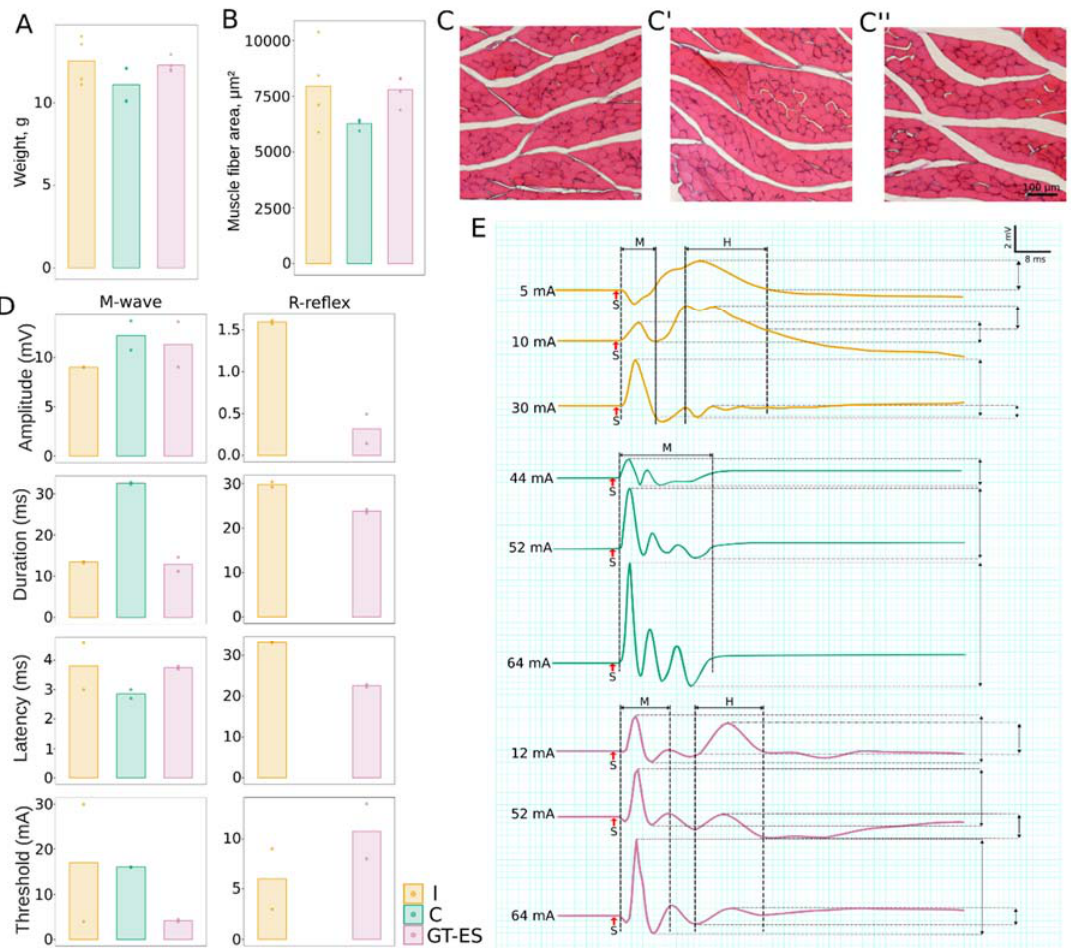
Figure 3. Assessment of hind limb skeletal muscles and an electrophysiological evaluation of M- and H-reflex. ( A ) Tibialis anterior muscles weighing analysis. ( B ) Evaluation of muscle fibers area in the tibialis anterior muscle. ( C , C ’, C ”) Cross sections of the tibialis anterior muscle stained with hematoxylin and eosin from I, C, and GT-ES groups, correspondingly. ( D ) Electrophysiological study of M- and H-reflex in the soleus muscle. ( E ) Parameters of the electromyography (EMG) signal. Data obtained for each animal are presented as points; bars represent group-wise average values.